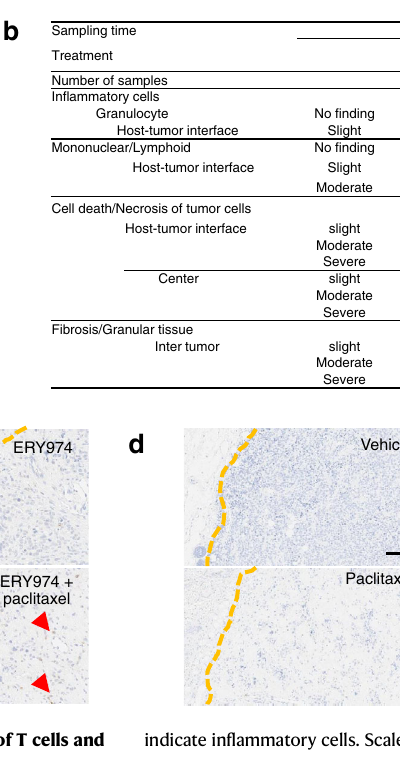
indicate in fl ammatory cells. Scale bar is 100 μ m b Histopathological analysis with HEstaining. c , d RepresentativeIHCforhCD3( c )andhCD68( d ).Yellowdottedline indicatestumour-stromalboundary;arrowsindicatehCD3-positive ( c )andhCD68- positive ( d ) cells. Scale bar is 100 μ m ( c ) and 200 μ m ( d